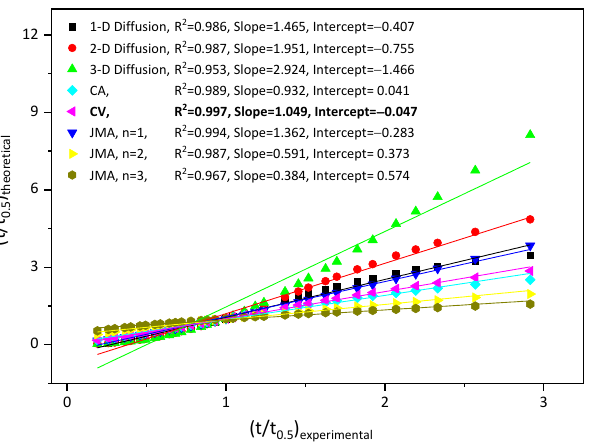
11 of 16 of 0.997, the slope close to 1, and the intercept equal to 0, amongst others, as shown in Figure 6. Comparison of this result with the data for the pristine Li-RHC and Li-RHC + 3TiCl 3 ∙ AlCl 3 samples given in [50] proves that the addition of AlTi 3 nanoparticles has changed the reaction mechanism for the hydrogenation of the Li-RHC system from a one-dimensional interface-controlled reaction to a three-dimensional interface-controlled reaction. 1-D Diffusion, R 2 =0.986, Slope=1.465, Intercept= - 0.407 2-D Diffusion, R 2 =0.987, Slope=1.951, Intercept= - 0.755 3-D Diffusion, R 2 =0.953, Slope=2.924, Intercept= - 1.466 CA,